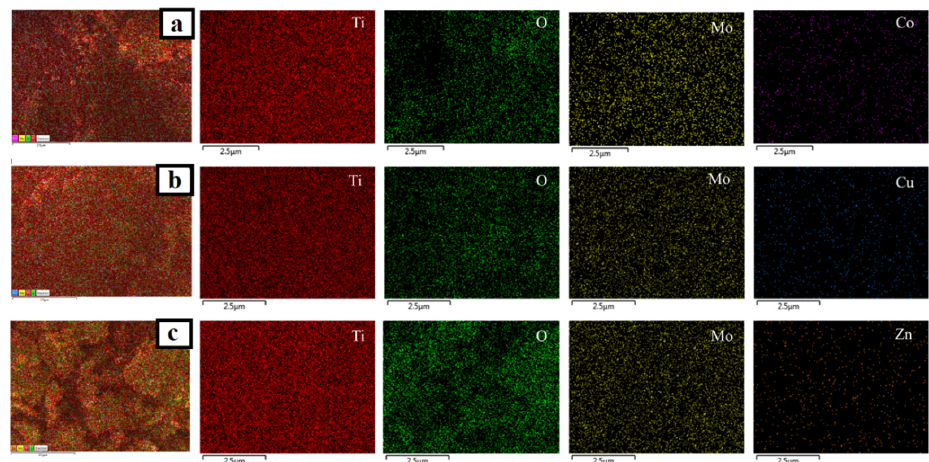
Figure 11. EDS mapping images of ( a ) Mo ‐ Cu ‐ TiO 2 , ( b ) Mo ‐ Co ‐ TiO 2 , and ( c ) Mo ‐ Zn ‐ TiO 2 .